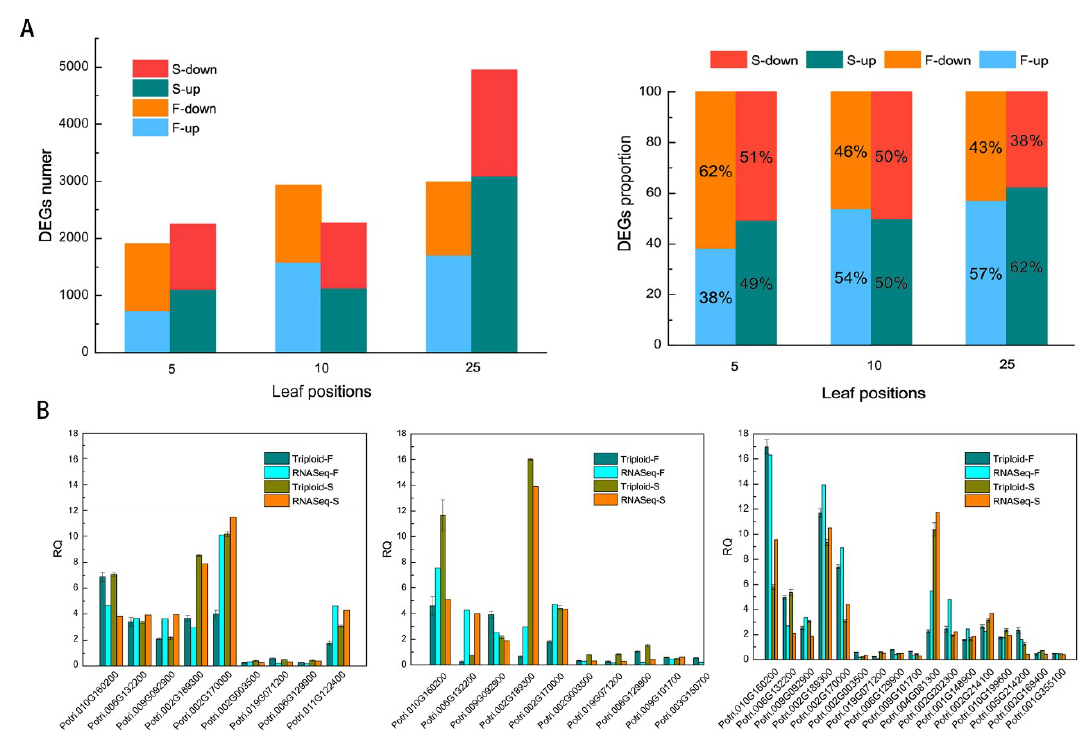
Figure 1. Transcription profile of di ff erentially expresssed genes (DEGs) and real-time polymerase chain reaction (RT-PCR) validation. ( A ) The numbers and proportions of upregulated and downregulated genes in the 5th, 10th, and 25th leaves of triploid-F and triploid-S plants; ( B ) RT-PCR verification of randomly selected DEGs in the 5th, 10th, and 25th leaves of triploid-F and triploid-S plants.